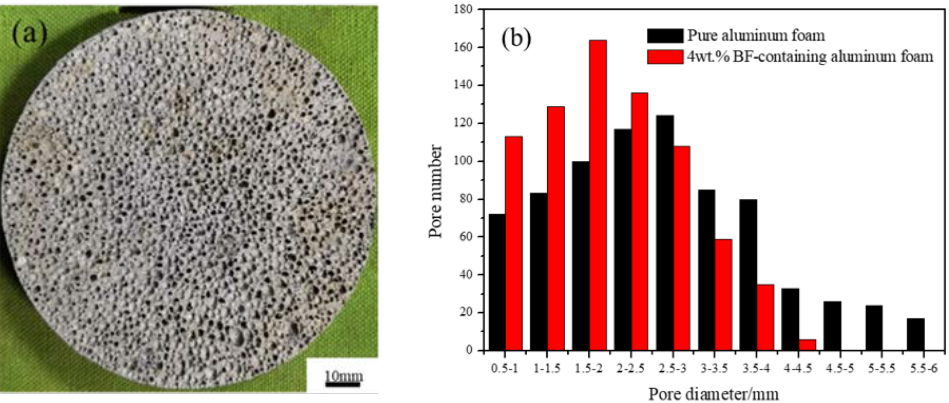
Figure 1. ( a ) Typical macrostructure; ( b ) pore size distribution.